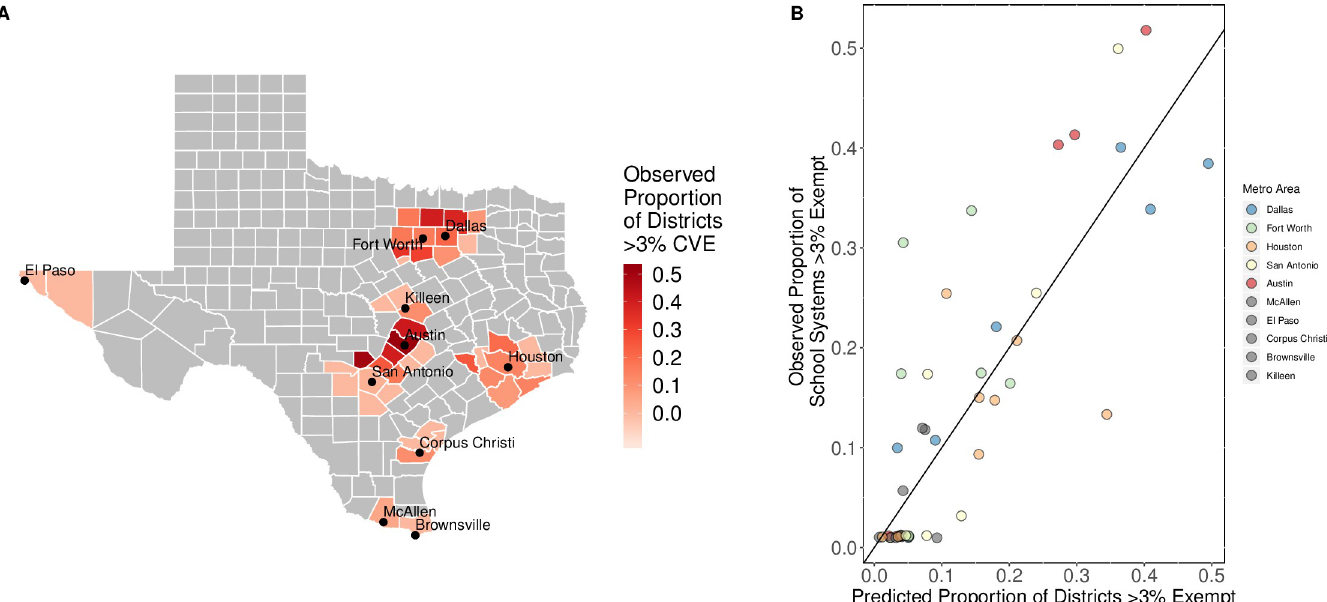
Fig 4. Observed and predicted proportions of schools above the 3% CVE threshold in the 10 largest metropolitan areas of Texas. (A) Red shading indicates the observed proportion of schools in each metropolitan county above the CVE risk threshold. Gray indicates nonmetropolitan counties excluded from the analysis. Base maps were sourced from the US Census Bureau’s Master Address File/Topologically Integrated Geographic Encoding and Referencing (MAF/TIGER) Database (MTDB) [50]. (B) Observed versus predicted proportions of schools at high risk, based on the fitted CVE risk threshold model. Each point represents a metropolitan county; non-gray shading indicates the top four metropolitan areas. The diagonal line indicates perfect agreement between the predicted and observed values. CVE, conscientious vaccination exemption.